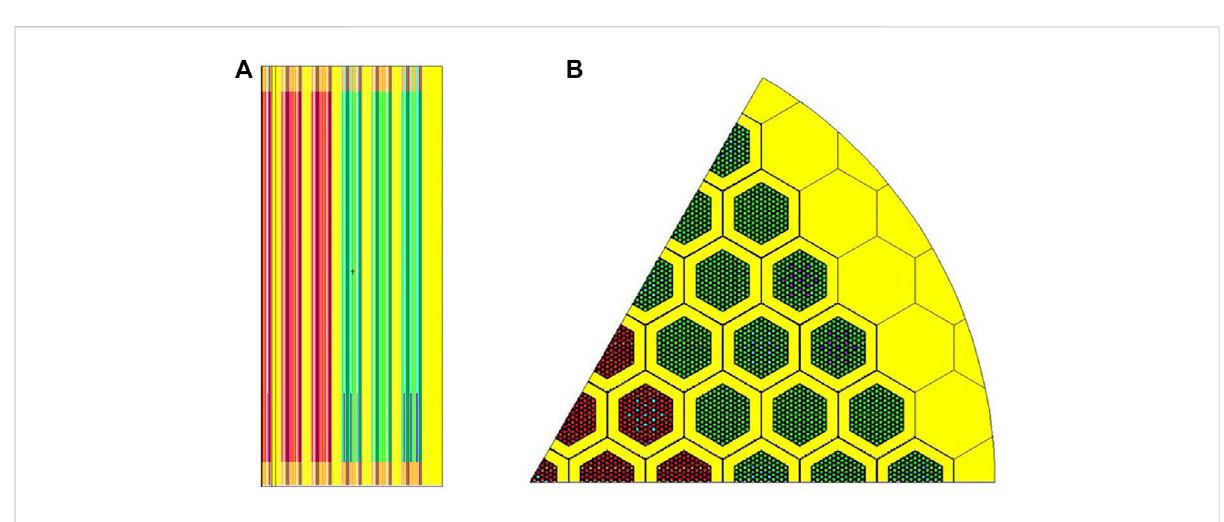
FIGURE 4 Core model in the MCNP. (A) Longitudinal section and (B) cross